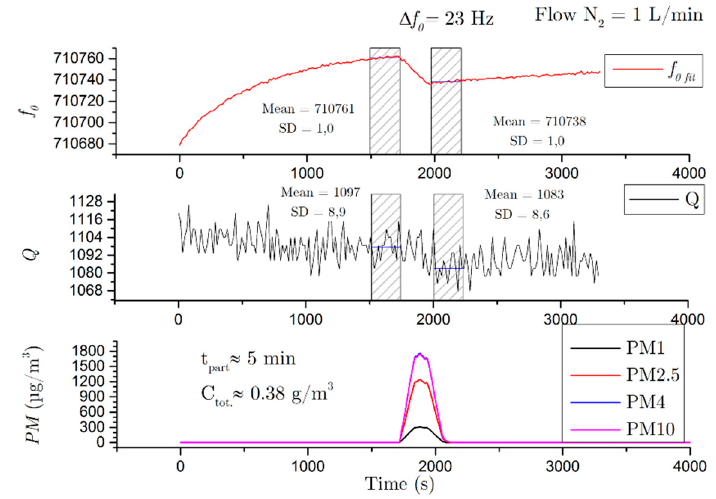
Figure 4. Resonant frequency f 0 , quality factor Q and PM evolution over time. tpart . is the duration of the dust exposure, and Ctot. the total of particles that transited in front of the microcantilever sensor. Mean value and standard deviation (SD) are indicated before and after dust input.